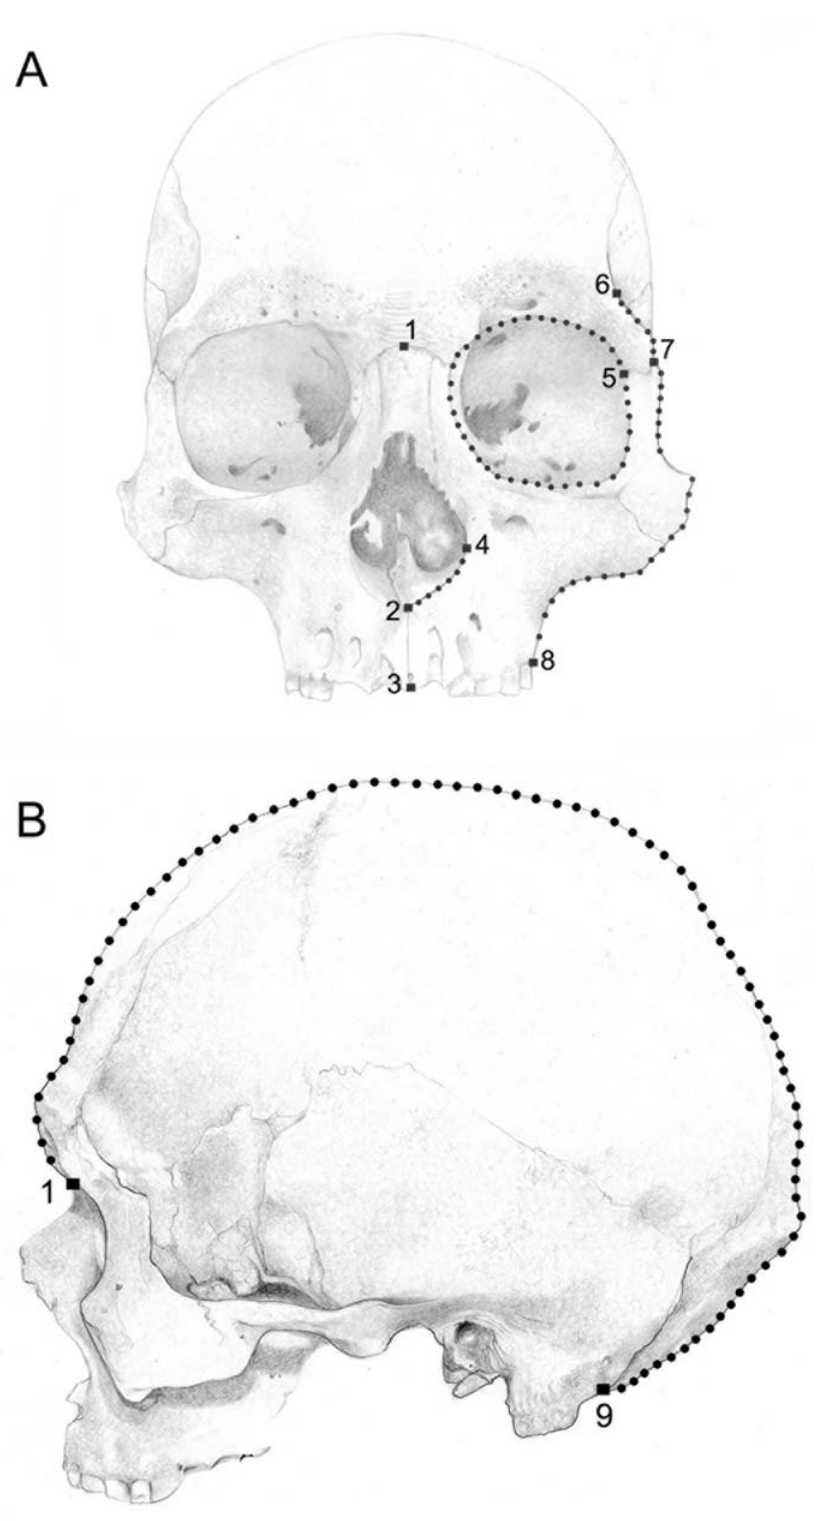
Figure 2. Allocated geometric coordinates are displayed with different symbols. Landmarks are represented as squares ( & ), whereas semilandmarks are represented as circles ( $ ) on face (A) and vault (B) views. The numbers correspond to the following landmarks: nasion (1); nasospinale (2); prosthion (3); alare (4); ectoconchion (5); frontotemporale (6); frontomalare temporale (7); ectomolare (8); post-mastoid (9).